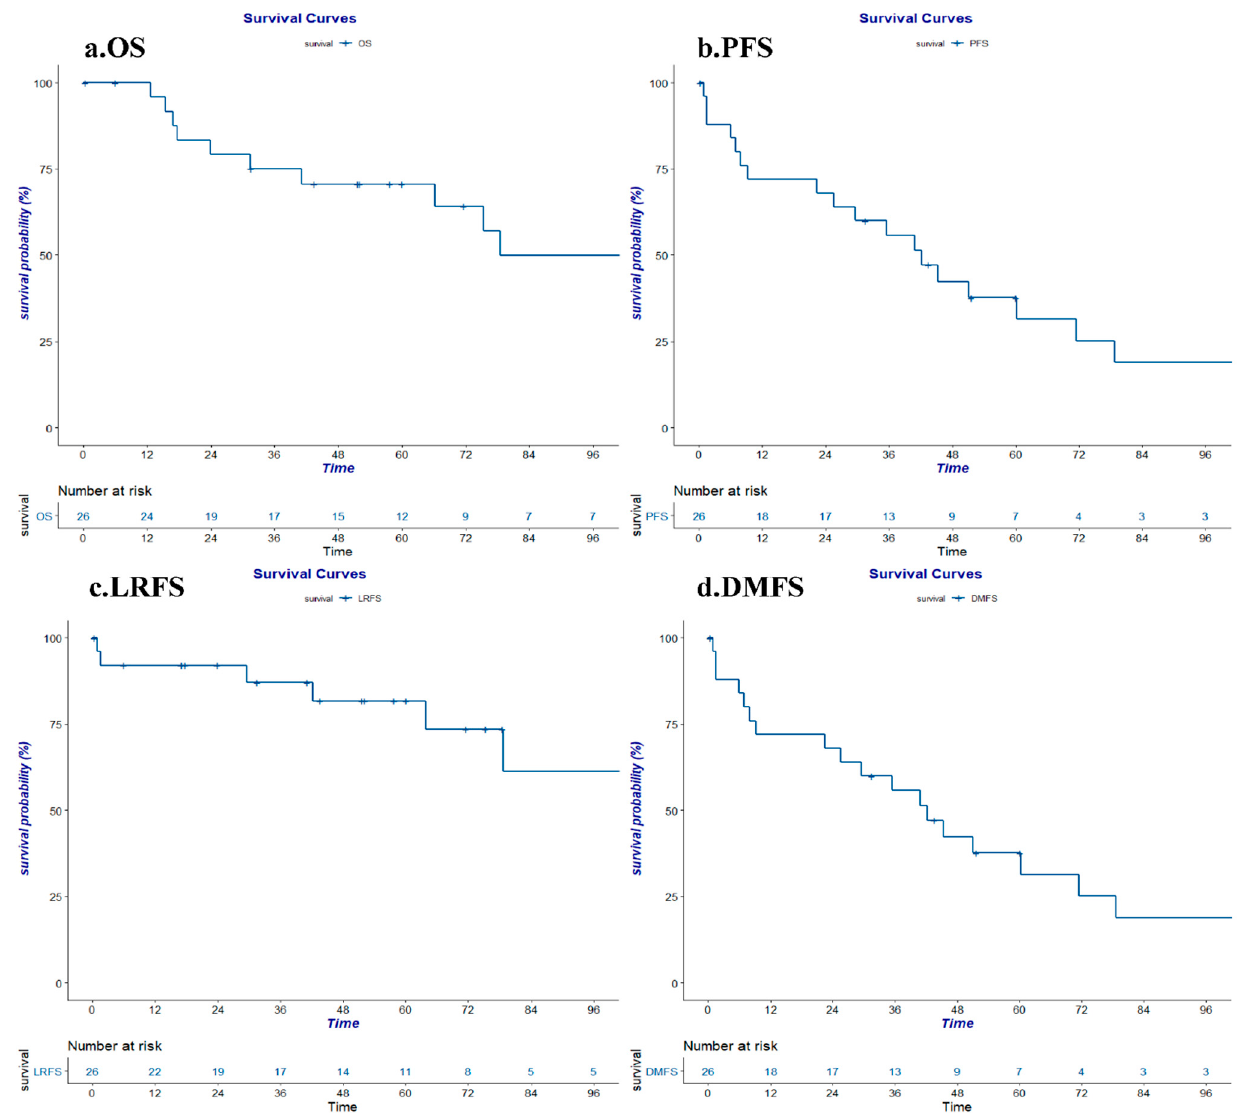
Figure 1. ( a ) OS: overall survival; ( b ) PFS: progression-free survival; ( c ) LRFS: local-regional relapse free survival; ( d ) DMFS: distant metastasis-free survival.